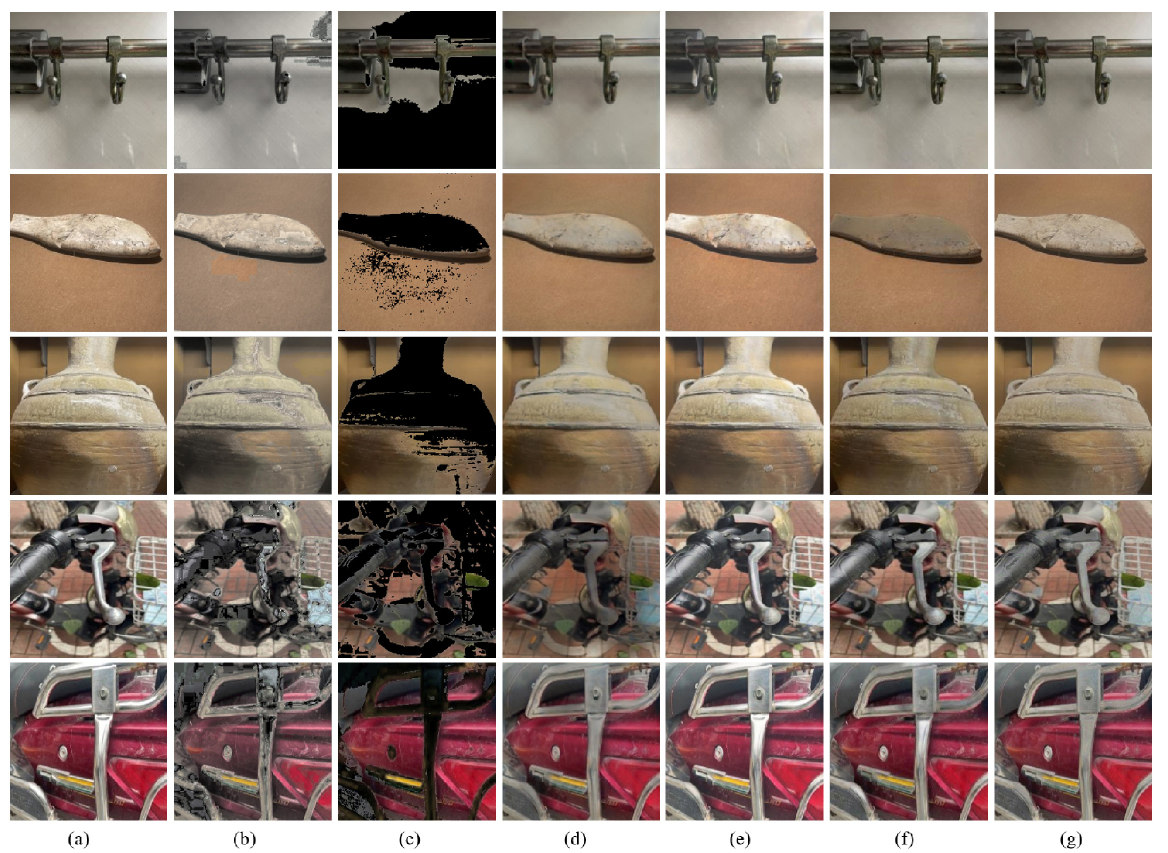
Fig. 6 Visual comparison on natural images in the wild: (a) input, and results from (b) Shen et al. [11], (c) Yamamoto et al. [59], (d) Multi-class GAN [16], (e) Spec-CGAN [46], (f) JSHDR [50], and (g) our method.